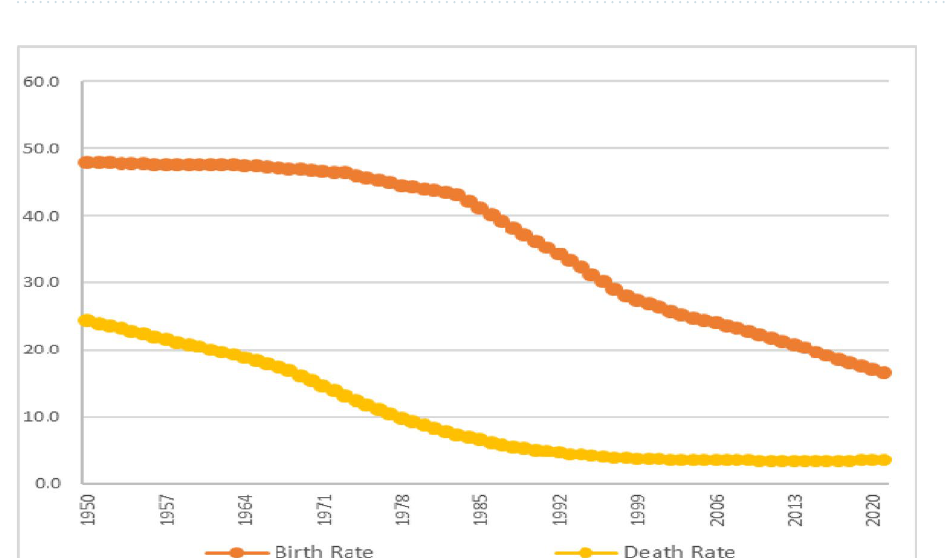
Figure 2. Demographic Transition in Saudi Arabia. Source: Saudi Arabia—Historical Birth Rate Data (https:// www. macro trends. net/ count ries/ SAU/ saudi- arabia/ birth- rate) (). Note: Caution is required as these figures are based on total population (natives and expatriates); most of the births and deaths of expatriates are recorded in their respective countries, and not in Saudi Arabia. But the denominator (mid-year population) might be inclusive of both native and expatriate